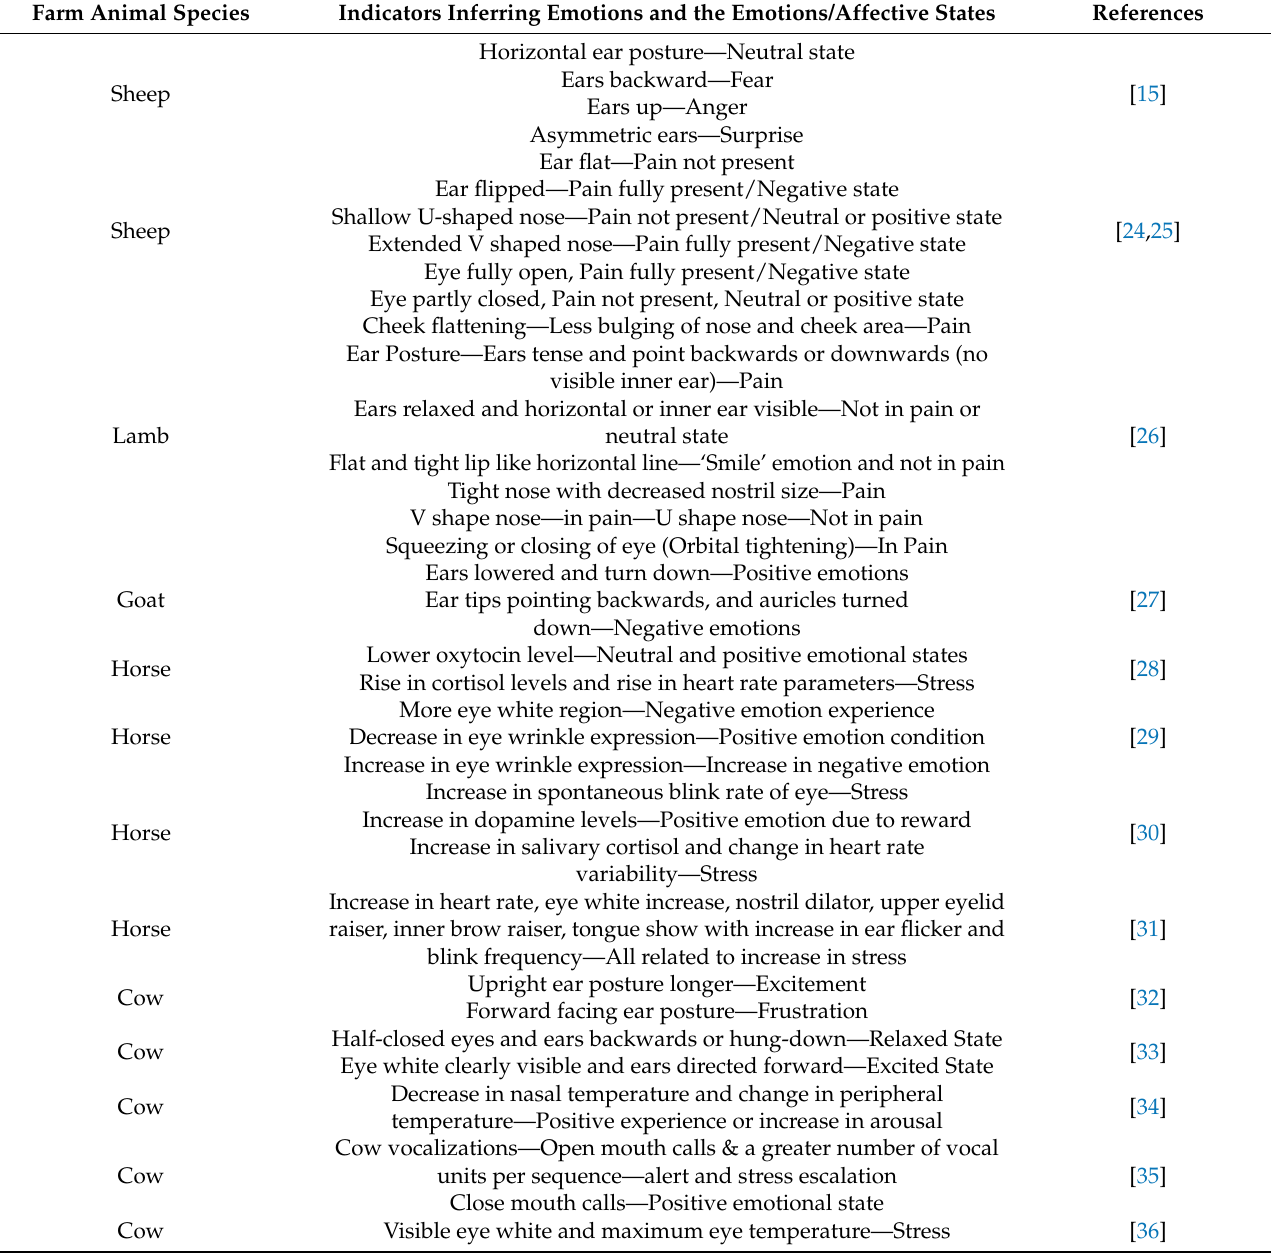
Table 1. Summary of emotions expressed by farm animals and sensing parameters related to recognize each emotion. Farm Animal Species Indicators Inferring Emotions and the Emotions/Affective States Horizontal ear posture—Neutral state Ears backward—Fear Sheep Ears up—Anger Asymmetric ears—Surprise Ear flat—Pain not present Ear flipped—Pain fully present/Negative state Shallow U-shaped nose—Pain not present/Neutral or positive state Sheep